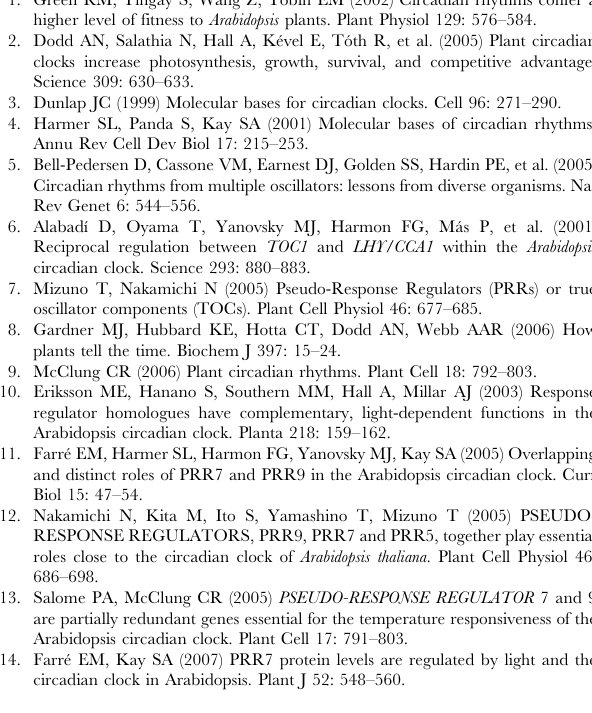
Figure S1 CsPRR gene expression in the leaves of adult chestnuts obtained in June. Leaves were collected in June at 3-h intervals. (A)